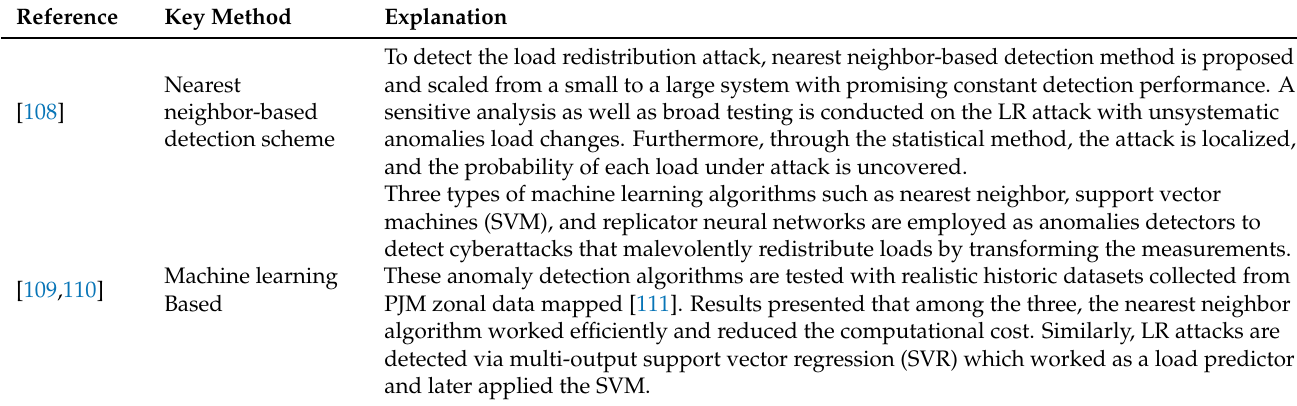
Table 8. Methods and countermeasures to defend against LRA